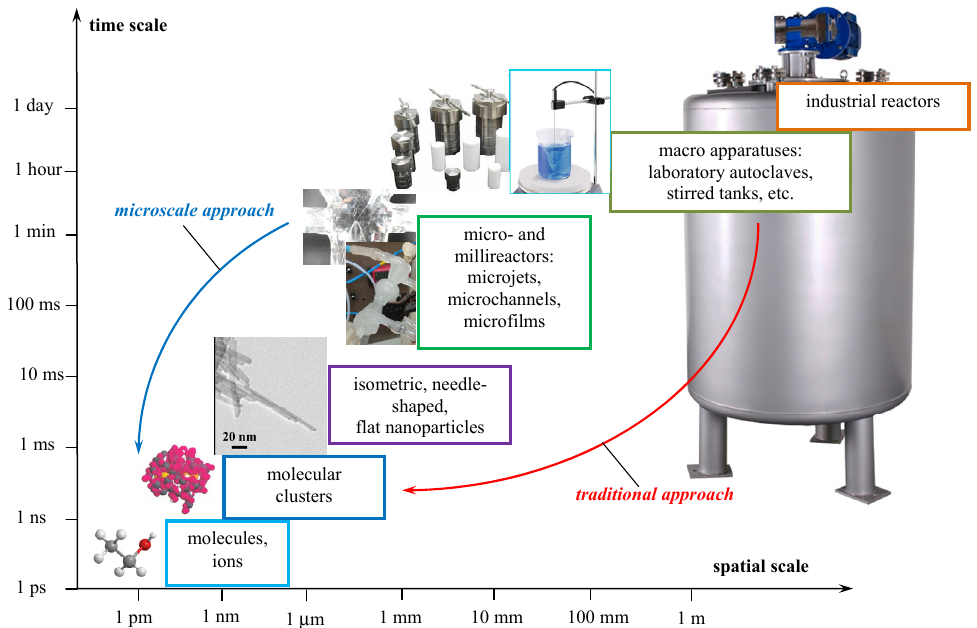
Figure 2. Spatial and temporal levels of formation of nanosized particle. Table 1. Examples of the implementation of processes for the synthesis of nanosized particles in microreactors of various types.